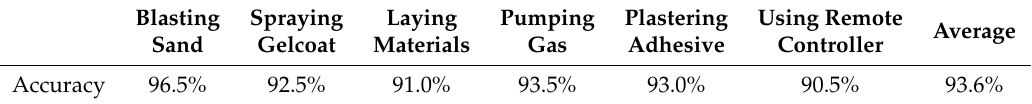
Table 3. The results of pose estimation of each operation.